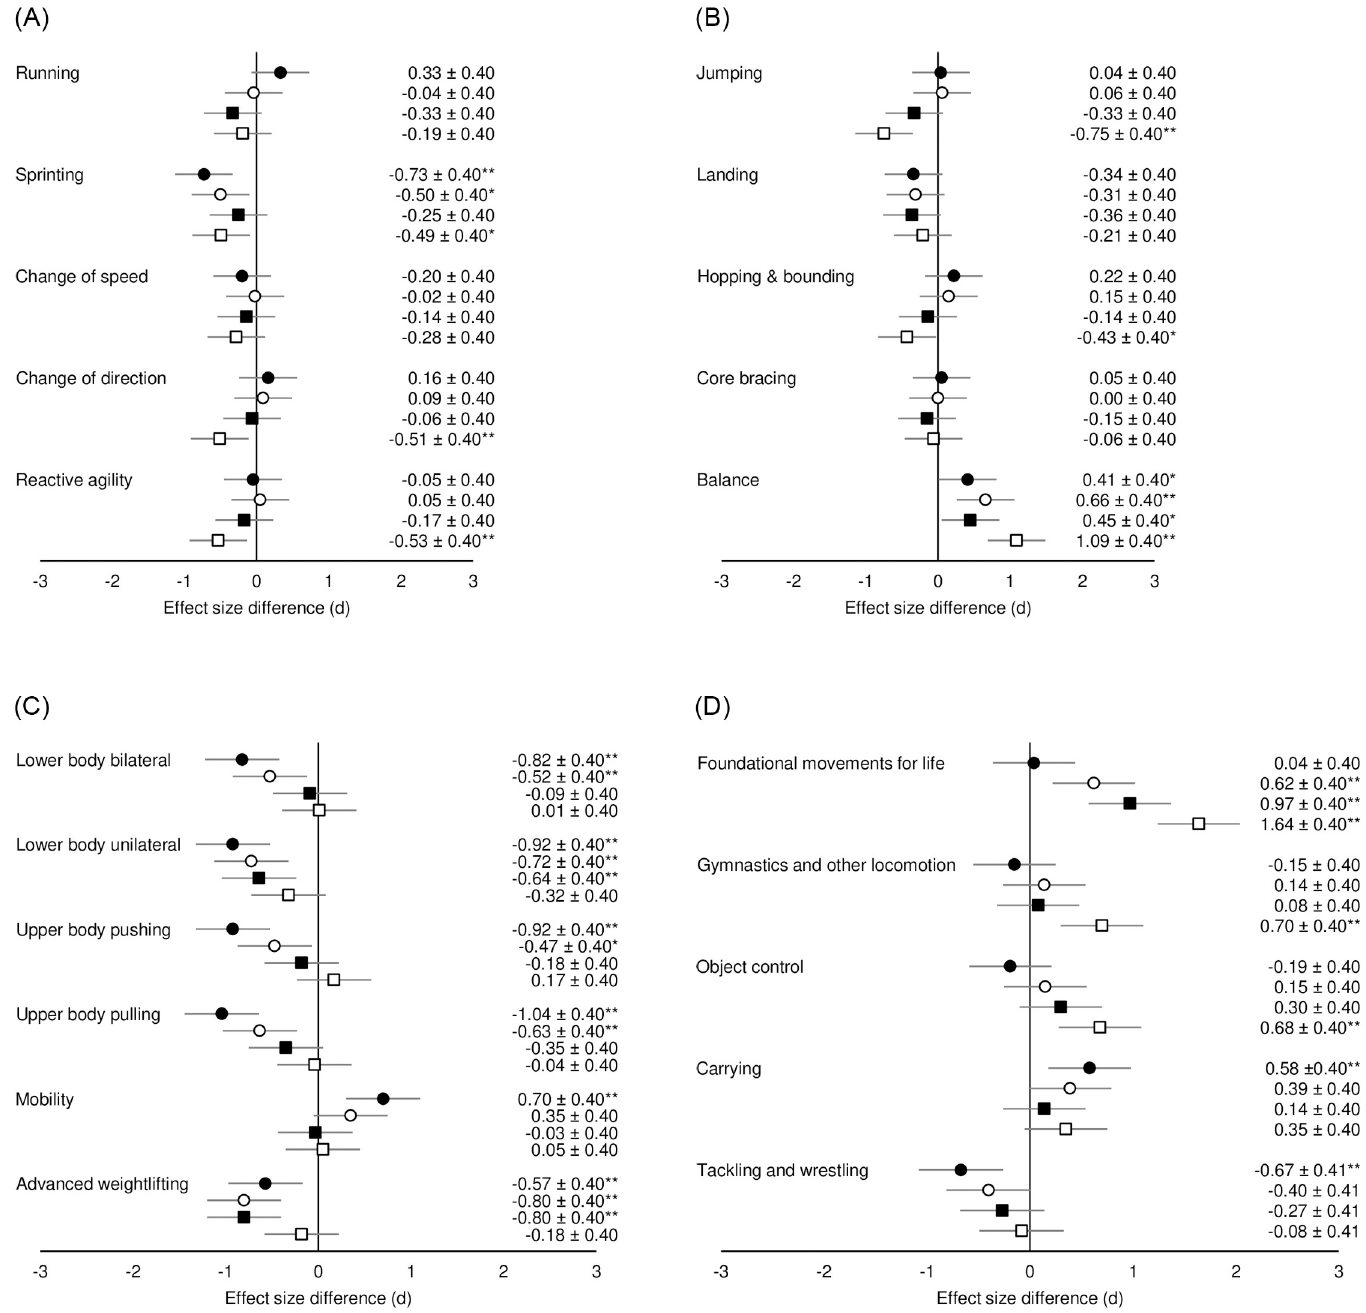
Fig 3. A. Effect size differences in perceived motor competence importance between PE teachers and S&C coaches across stages of maturity for running-based competencies. B. Effect size differences in perceived motor competence importance between PE teachers and S&C coaches across stages of maturity for jumping and stability competencies. C. Effect size differences in perceived motor competence importance between PE teachers and S&C coaches across stages of maturity for strength- based competencies. D. Effect size differences in perceived motor competence importance between PE teachers and S&C coaches across stages of maturity for other fundamental/foundational competencies. Black circles = childhood; white circles = pre-PHV; black squares = circa-PHV; white squares = post-PHV. Negative effect size = PE teachers rated the motor competency less important than S&C coaches; positive effect size = PE teachers rated the motor competency more important than S&C coaches. � p < 0.05, �� p <